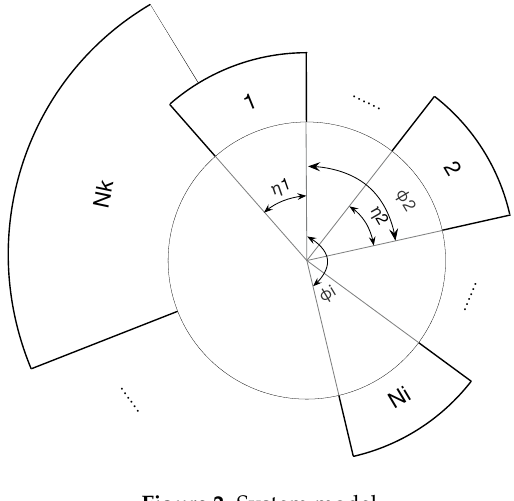
Figure 2. System